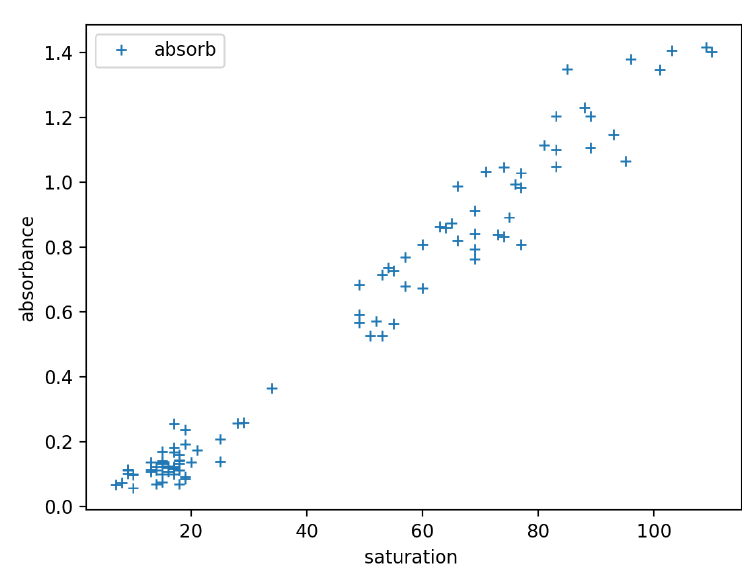
Figure 6. Absorbance vs. saturation, blue samples. Table 2. R 2 between absorbance and the square of saturation of selected